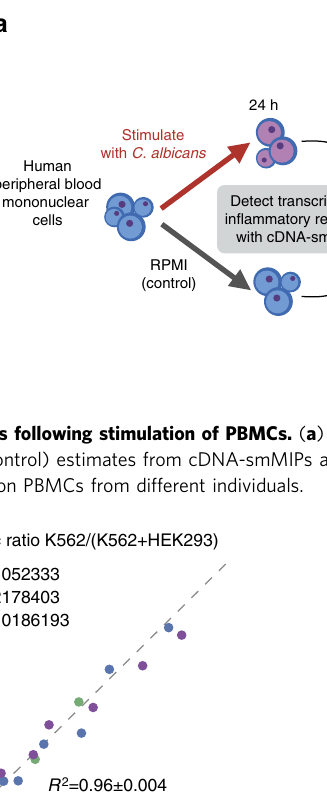
Figure 6 | Cost comparison. Reported cost is per sample, assuming a total of 1,000 samples, starting from RNA and including library preparation and sequencing. Breakdown of cost for cDNA-smMIPs is given in Supplementary Table 7. For cDNA-smMIPs and qPCR, calculation is based on 100 target regions in 20 genes; reported cost also includes cDNA synthesis (iScript), purification and measurement of cDNA concentration (8.25 USD). Cost for RNA-Seq is based on Illumina Truseq V2 kit (48 reactions, 3,724 USD, assuming 5 million paired-end reads on Illumina NextSeq at cost of USD 32.49). Cost for CaptureSeq is based on same Illumina Truseq V2 kit (48 reactions) followed by capture with Nimblegen SeqCap in 5-plex capture (87 USD/sample) as previously described 5,35 and 5 million paired-end reads on Illumina NextSeq(USD 32.49). The current commercially available version of SeqCap also permits 12-plex